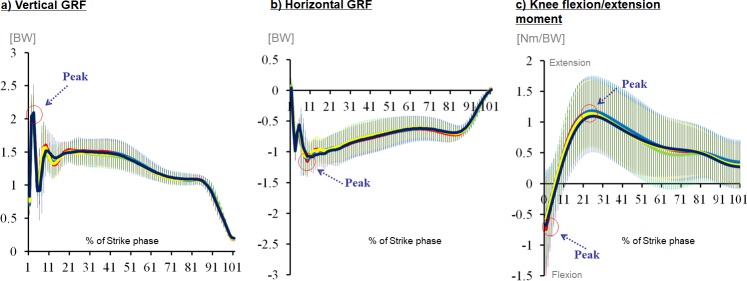
Typical curves of a) vertical GRF, b) horizontal GRF and c) knee flexion/extension moment.